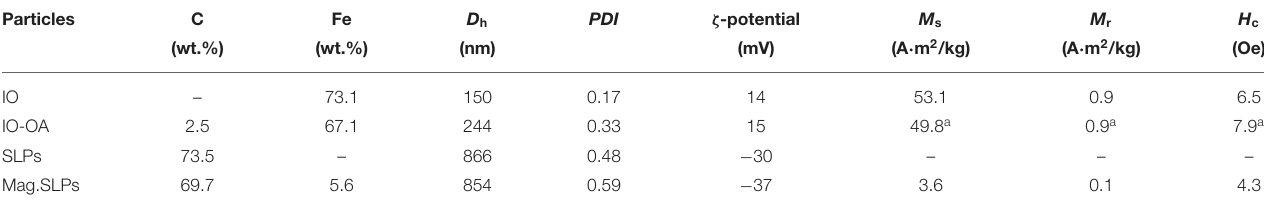
TABLE 1 | Composition and properties of the particles.